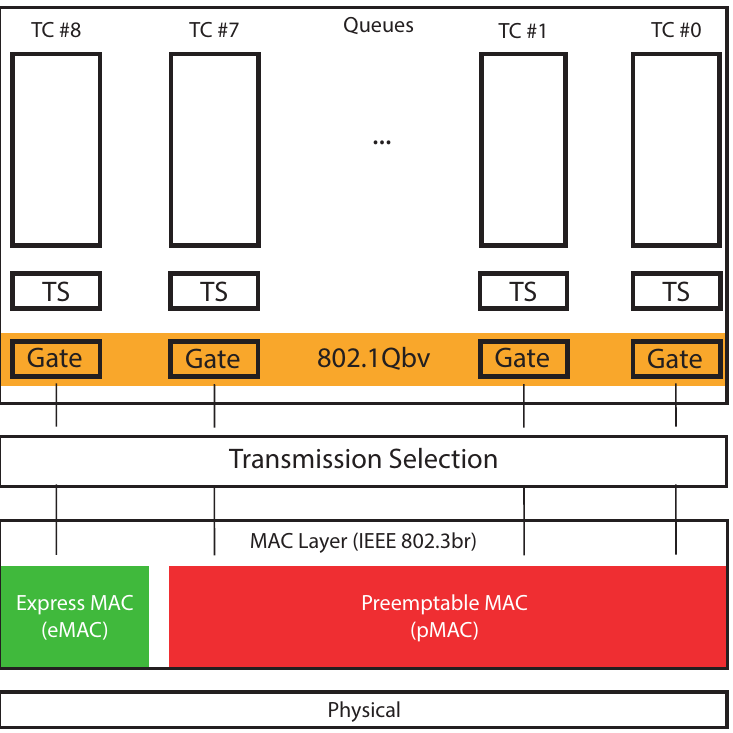
Figure 8. The queuing and forwarding process within IEEE